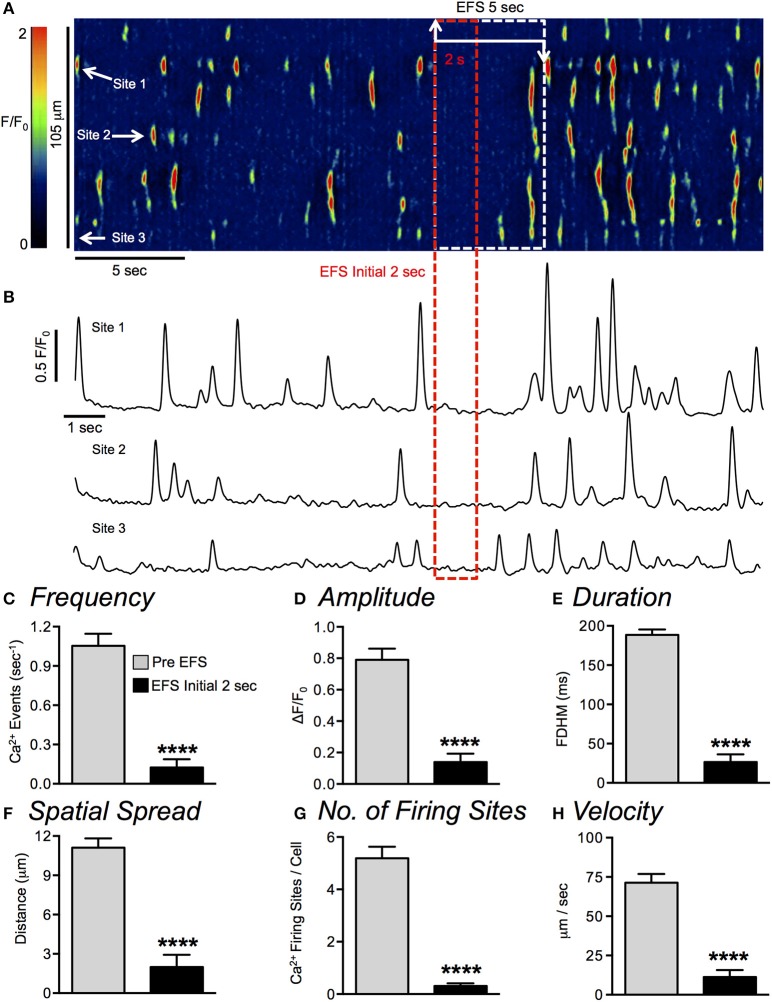
Ca2+ transients in ICC-DMP are inhibited after initiation of nerve stimulation. (A) Representative ST map of Ca2+ transients in a single ICC-DMP taken from a recording in situ (60x objective). A color-coded overlay and calibration scale was imported to depict fluorescence intensity (F/F0) and enhance visualization of Ca2+ sites. Low fluorescence areas are indicated in dark blue or black. High intensity fluorescence areas are indicated in red and orange. EFS (10 Hz, for 5 s) was applied, as indicated by the white dashed box. The red dashed box highlights the initial 2 s of EFS. The white arrows near the beginning of the ST map indicate 3 specific Ca2+ firing sites and their firing activity is plotted in the traces shown in (B). (C–H) Summary data quantifying the effects of nerve evoked responses on ICC-DMP Ca2+ transient frequency (C), amplitude (D), duration (E), spatial spread (F), number of Ca2+ firing sites (G) and Ca2+ transient velocity (H) during the initial 2 s of EFS (n = 19, c = 48). All statistical analyses are in comparison to the pre-EFS period. ****P < 0.0001.